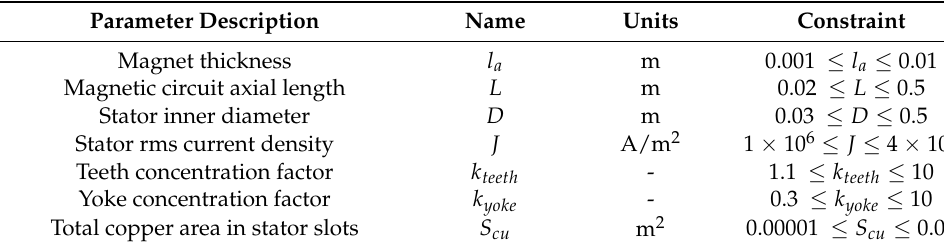
Table 4. Optimization variables for SM.